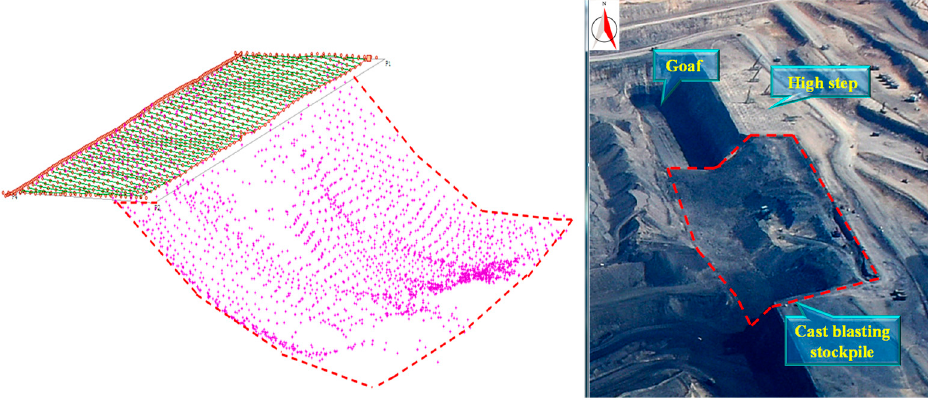
Figure 3. 3D model of cast blasting stockpile.